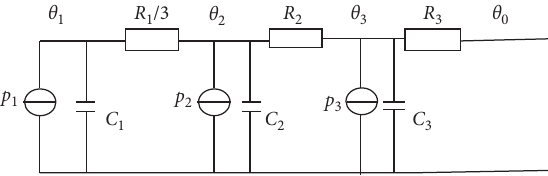
Figure 5: Modeling of a power cable’s transient thermal circuit simplified.